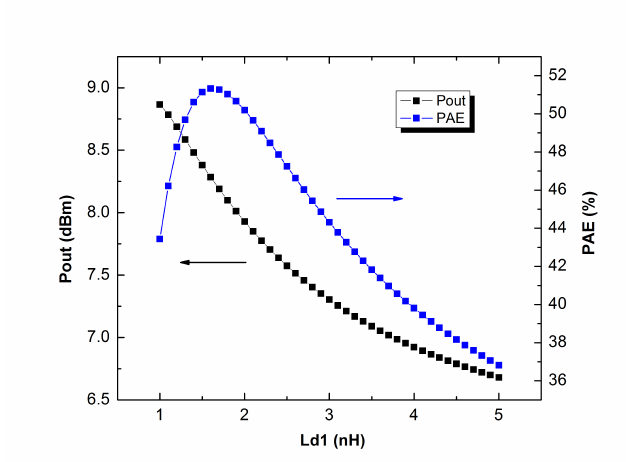
Figure 22. Output performance versus first-stage RF choke L